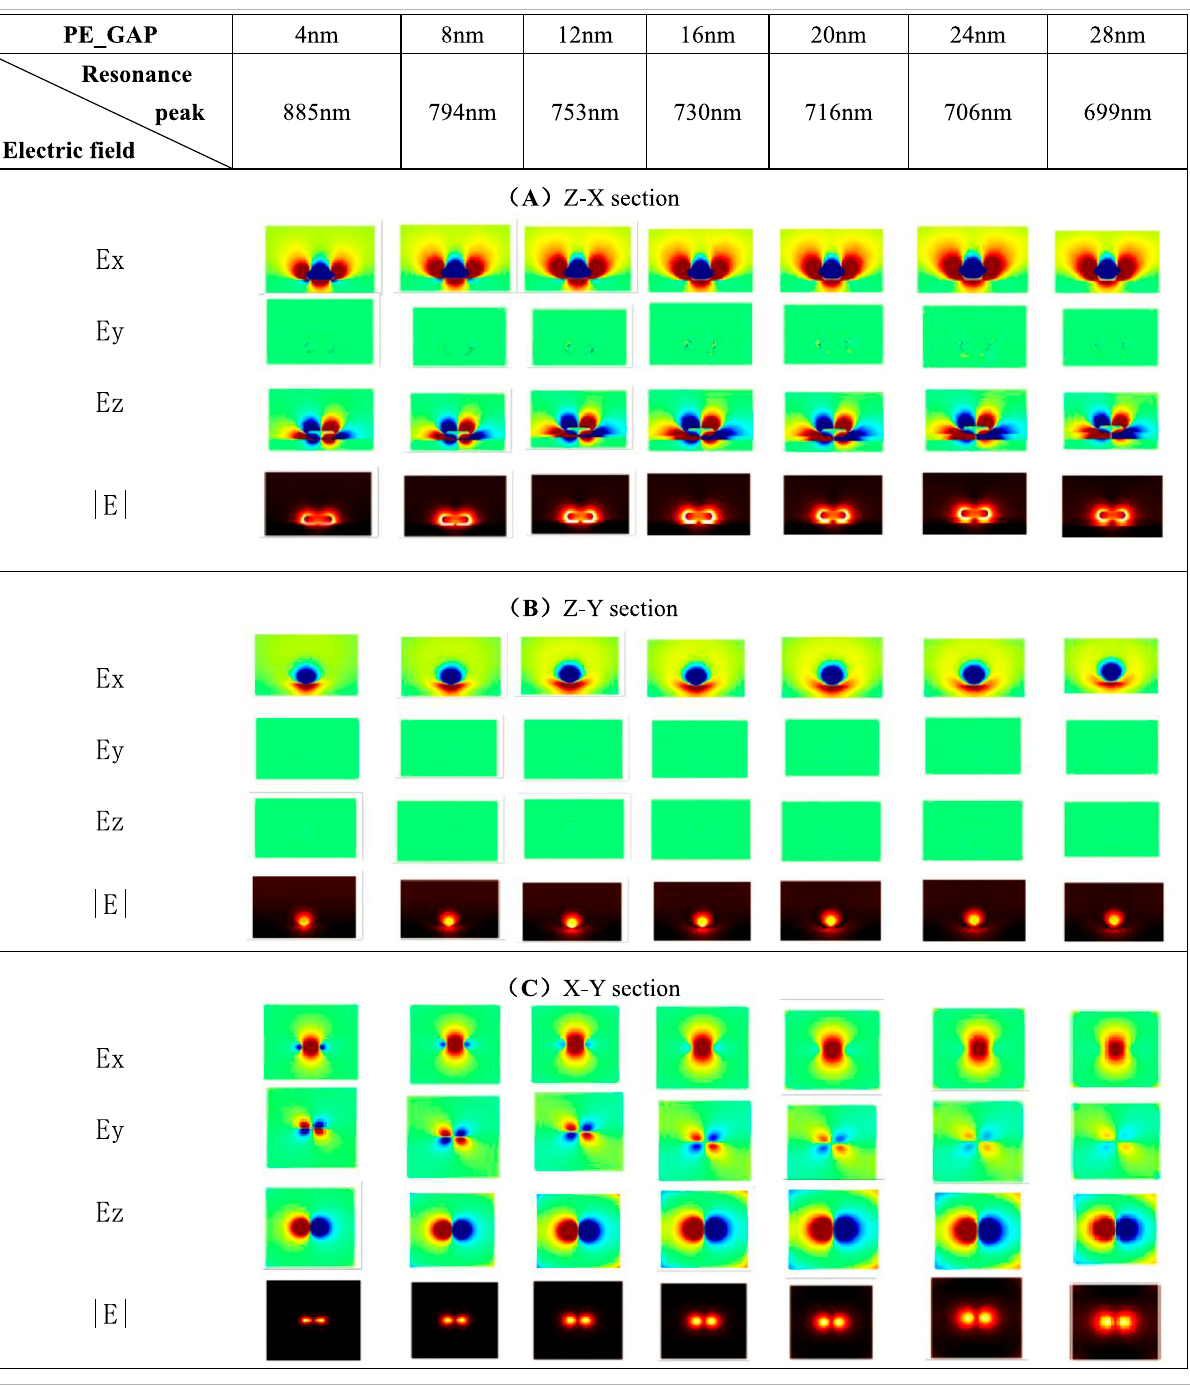
TABLE 1 | The electric fi eld section at the resonance peak at different PE interval